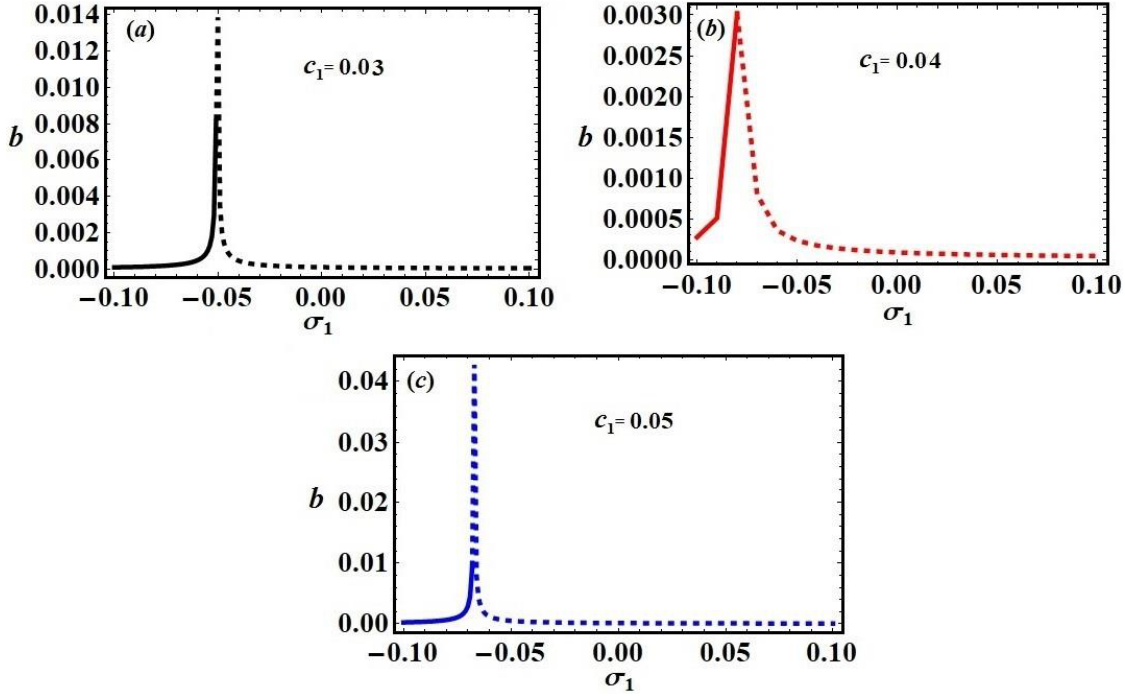
Figure 13. Frequency response curves of b at ω 1 = 2.5, σ 2 = 0.003: ( a ) c 1 = 0.03, ( b ) c 1 = 0.04, ( c ) c 1 = .